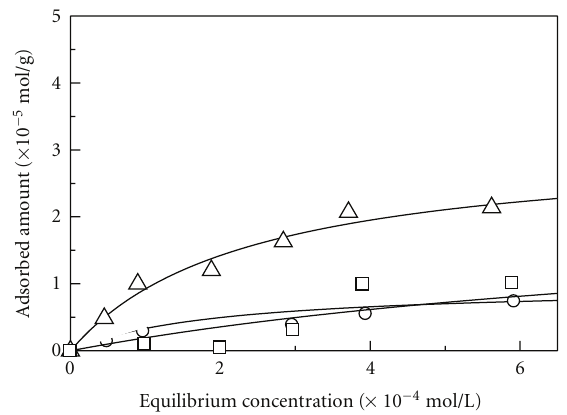
Figure 9: Adsorption isotherms of Evans blue on the titanium oxide nanoparticles in aqueous solution of dye. The concentrations of NH 3 (aq) used to prepare the titanium oxide nanoparticles were the following: (cid:3) , 1 mol/L; (cid:2) , 0.2 mol/L; and (cid:4) , 0.1 mol/L.